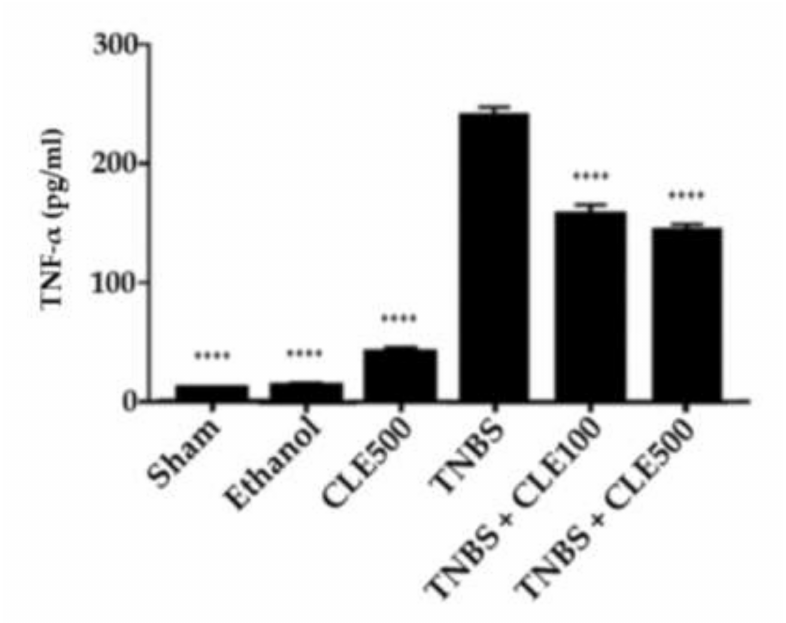
Figure 5. CLE influence on TNF- α levels in IBD context. Legend: One-way ANOVA and Tuckey’s post hoc test; **** p < 0.0001, in comparison to the TNBS group. Abbreviations: CLE, C. cardunculus L. extract; TNBS, 2,4,6-trinitrobenzene sulfonic acid; TNF- α , tumor necrosis factor- α .